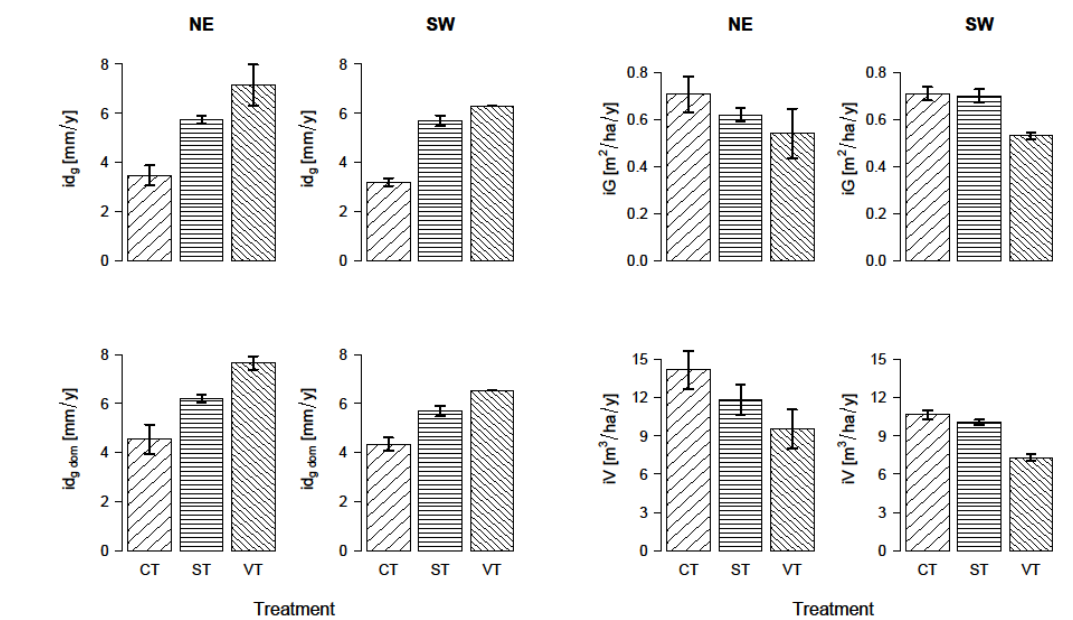
Figure 2. Growth response to thinning according to aspect for all treatments: control (CT), strong thinning (ST), and very strong thinning (VT). Measured parameters: mean stand diameter increment ( id g ), mean stand diameter increment of dominant trees ( id g dom ), stand basal area increment ( iG ) ,and stand volume increment ( iV